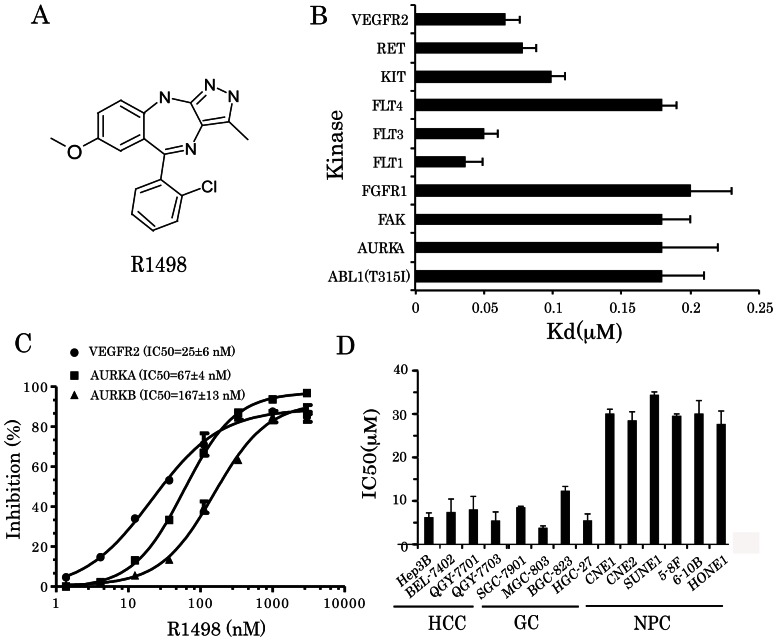

In vitro activity of R1498.(A) Chemical structure of R1498; (B) R1498 was subjected KINOMEScan® and the most potent hits with Kd< 0.2 µM are shown; the assay was carried out in triplicate, and data were presented as mean±standard deviation; (C) R1498 was tested in Z-lyte kinase assays including VEGFR2, Aurora A and B, the dose response curve was shown and mean IC50 values from three independent experiments were indicated. (D) The in vitro anti-tumor growth activity of R498 was assayed on 16 cell lines including HCC, GC and NPC. Data from triplicated independent assays were presented as mean±standard deviation.